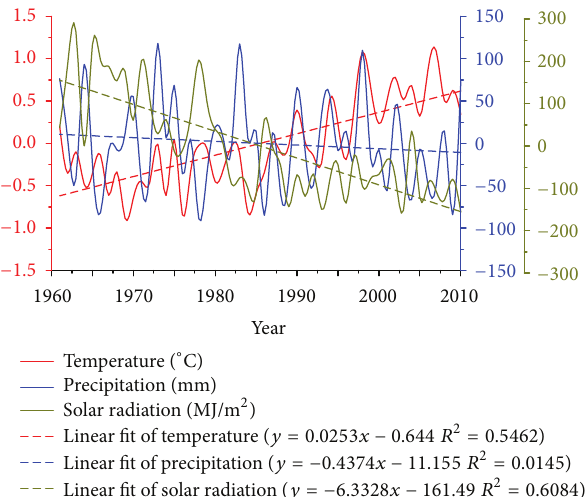
Figure 5: Annual anomaly maps of each climatic factor during the past five